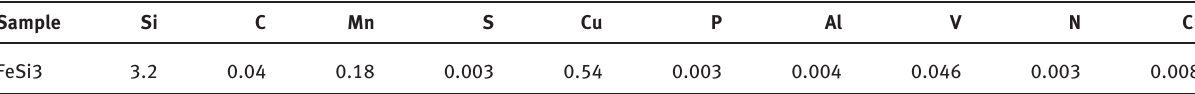
Table 1: Chemical composition of tested materials (in wt%).